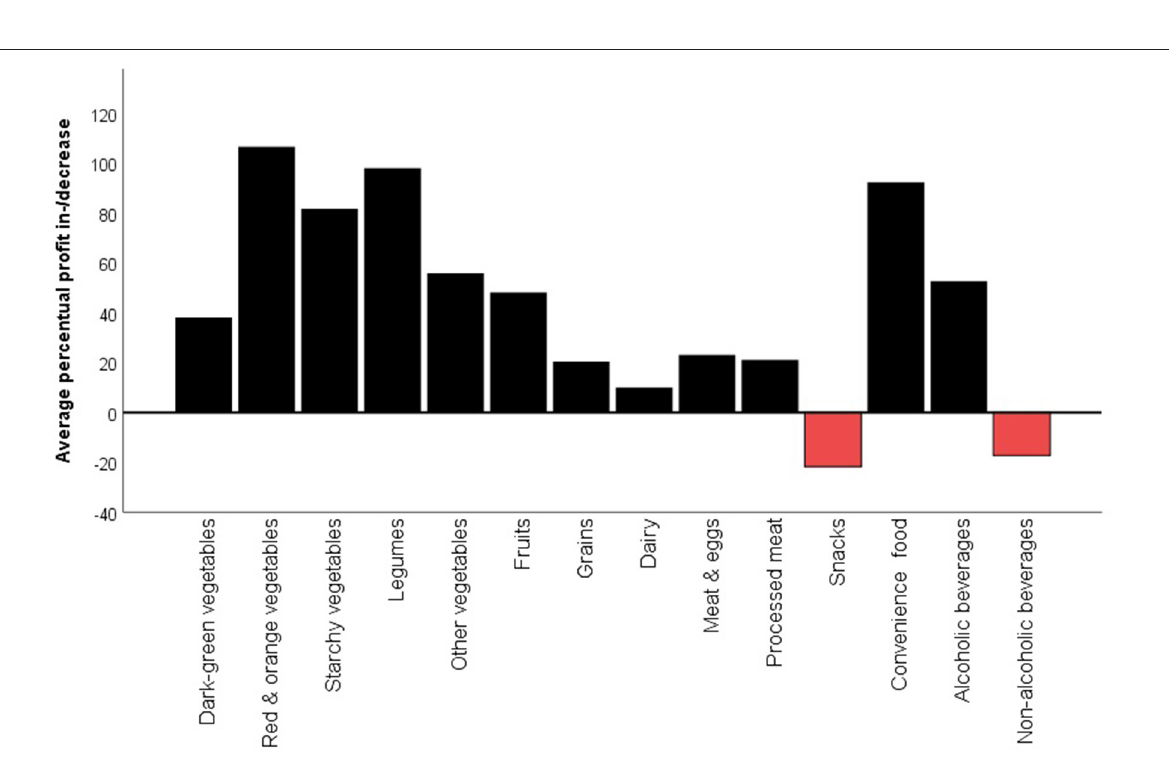
Frontiers in Sustainable Food Systems |